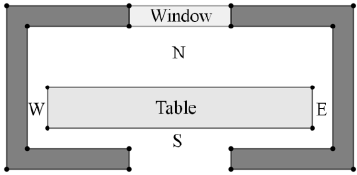
Figure 6. The problem of balancing the deflation of space. Subspaces W, E and S will fully deflate before N. When this happens the partial deflation of N becomes an island.